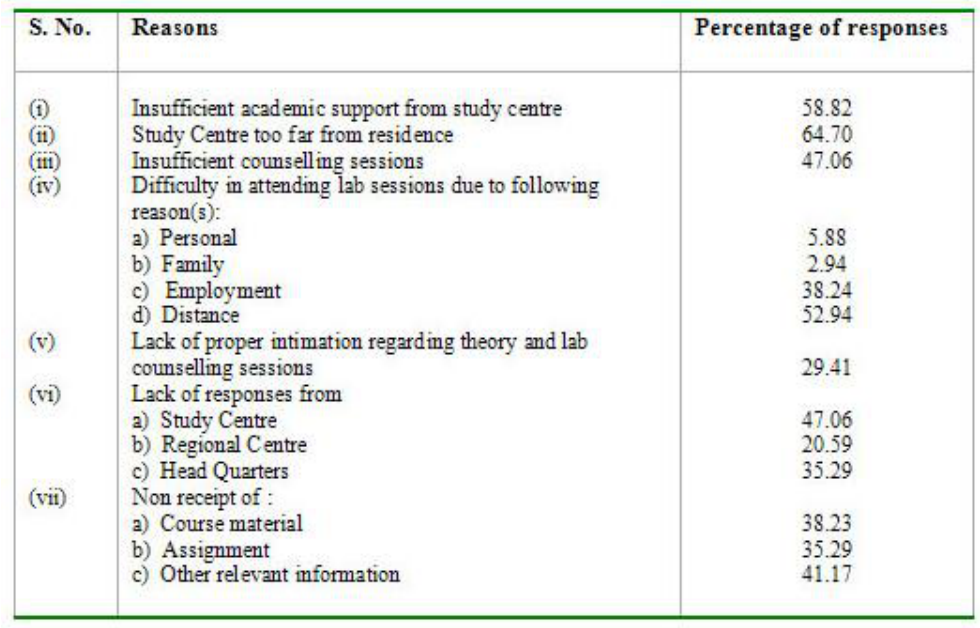
Table 4. Student support related reasons as response for withdrawal (expressed as a percentage of total number of